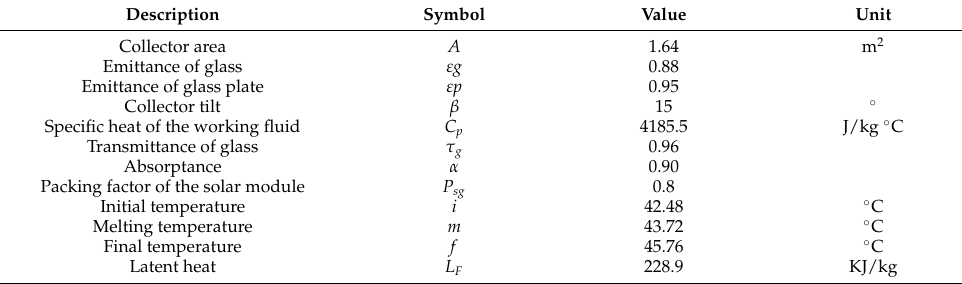
Table 3. Characteristics of the PVT and PVT-PCM